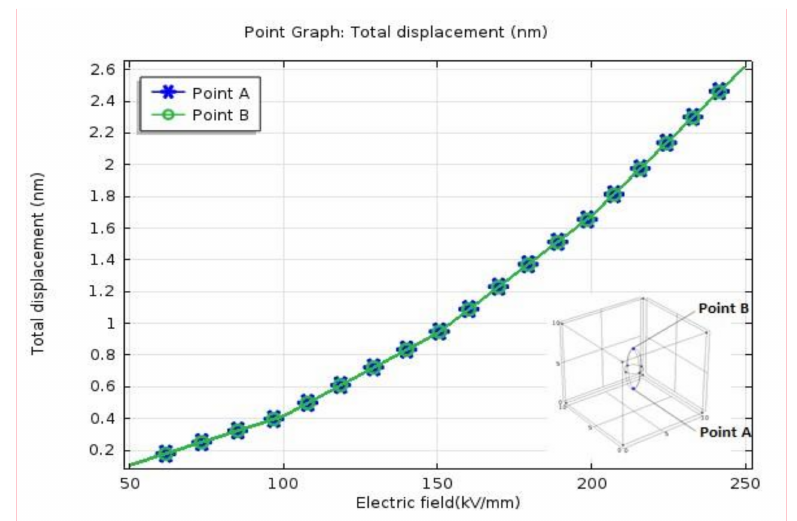
Figure 12. Total displacement with increasing electric